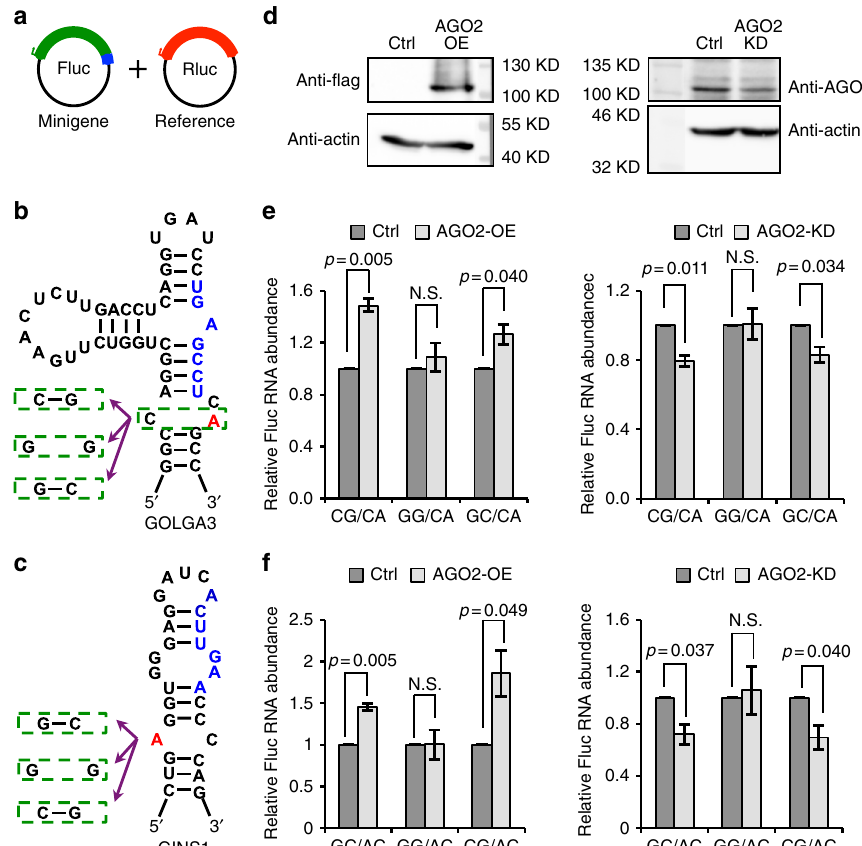
Fig. 7 RNA editing-induced secondary structural changes affect RNA abundance. a Schematic diagram of the minigene system. Target sequences (3 ′ UTRs of GOLGA3 and GINS1 ) and their mutant versions were inserted into the fi re fl y luciferase (Fluc) 3 ′ UTR. Renilla luciferase (Rluc) was used as a reference reporter. Fluc and Rluc were co-transfected into HEK 293 control cells, AGO2 overexpression (OE) and AGO2 knockdown (KD) cells. RT-qPCR was carried out 48 h after transfection (details described in Methods). Green region represents fi re fl y luciferase, red region represents Renilla luciferase and blue represents inserted target sequences or mutant versions. b Predicted RNA secondary structure of GOLGA3 3 ′ UTR fl anking the RNA editing site. The “ A ” nucleotide at the editing site is highlighted in red. Blue sequences correspond to predicted miRNA target site (of the miRNA seed region). Green dashed boxes illustrate the unedited (A), pre-edited (G) and mutant nucleotides and their counterpart bases in the predicted RNA secondary structure, respectively. c Similar as b , but for the GINS1 gene. d Western blot of AGO2 expression in control cells and cells with AGO2 OE or KD. e , f Relative RNA expression levels of minigenes with unedited, pre-edited or mutant versions of the sequences shown in b and c respectively. Fluc and Rluc vectors were co-transfected into HEK293 control (Ctrl) cells and cells with AGO2 -OE (left panel) or AGO2 -KD (right panel). Relative Fluc RNA abundance between pre-edited (or mutant) and unedited versions of the minigenes is shown (see x -axis labels). Error bars represent standard deviation based on three experimental replicates. P values were calculated using Wilcoxon Rank-Sum test. N.S . not signi fi cant ( p ≥